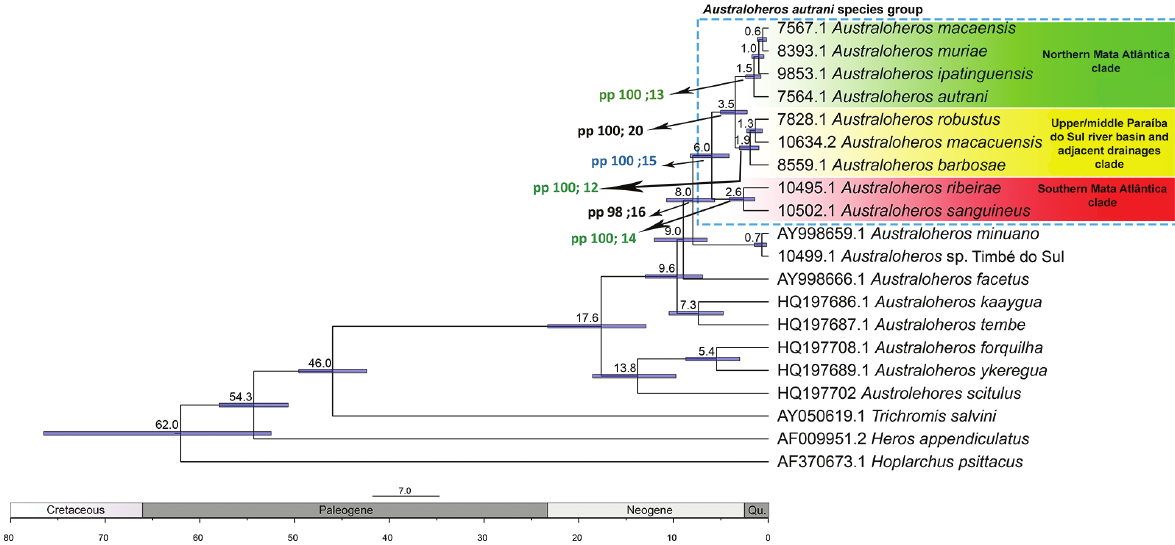
Figure 4. Time-scaled phylogeny obtained from the Bayesian analysis in BEAST. Values above nodes are mean average ages of the nodes, followed below blue bars representing the 95% highest posterior densities intervals for estimated ages; numbers indicated by arrows are the posterior probability obtained from the Bayesian analysis in MrBayes followed by the node number, corresponding to the node numbers of the Figure 2 and Box 1. PP means posterior